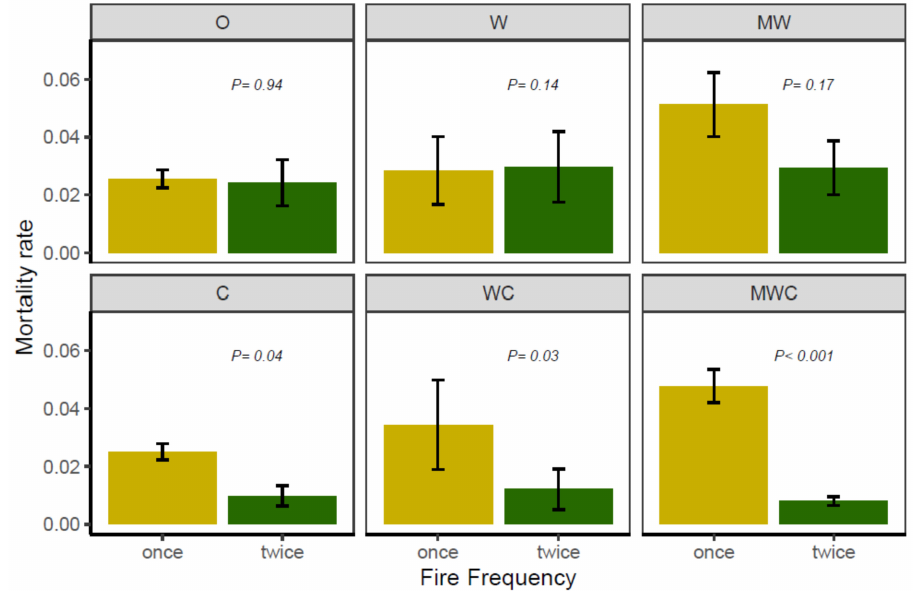
Figure 3. Effects of herbivores and fire frequency on tree mortality. p values on top of the bars are obtained from all pairwise caparisons using emmeans in the R package emmeans [34].